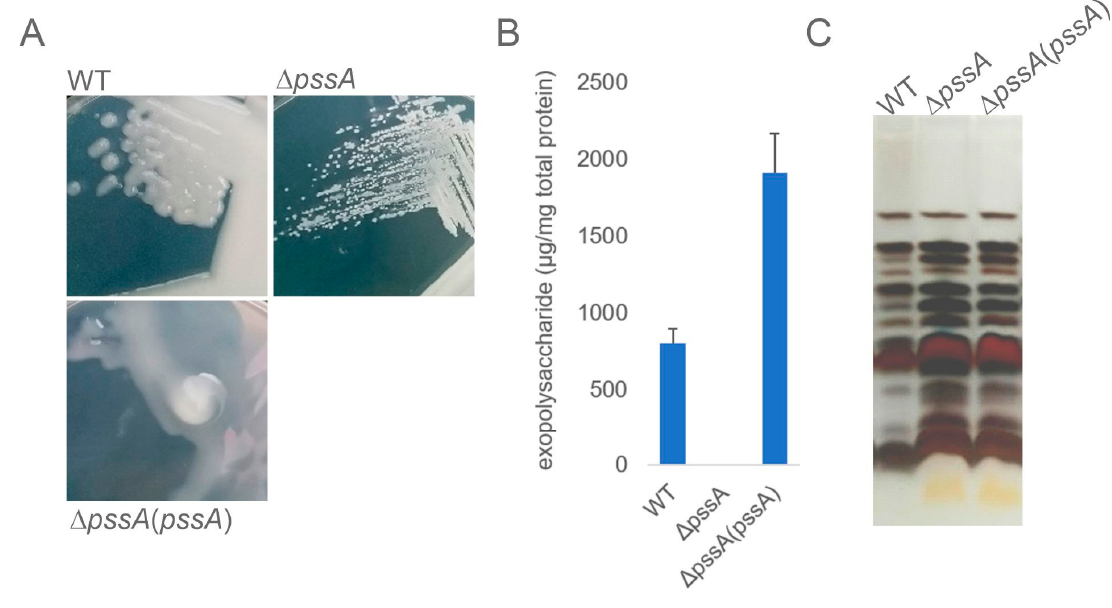
Figure 1. Analyses of polysaccharides produced by the ∆ pssA mutant and its complemented derivative. ( A ) Microscopic morphology of single colonies formed on 79CA agar plates. ( B ) Result of the quantification of exopolysaccharides secreted into the liquid culture. The amount of sugar in tested samples was determined based on the calibration curve prepared for glucose and expressed as the total sugar content per amount of total bacterial protein ( µ g/mg). Error bars represent standard deviation. ( C ) Profiles of LPS of the tested strains separated in Tricine-PAGE electrophoresis and stained with silver.